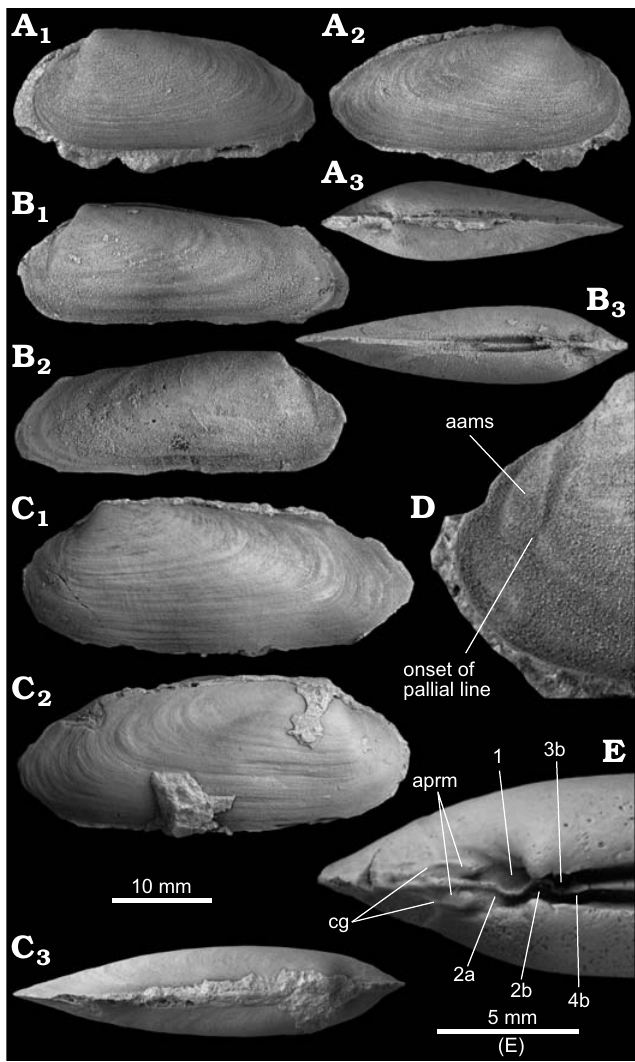
Fig. 6. The vesicomyid Pleurophopsis lithophagoides Olsson, 1931, from the early Oligocene Belén seep site, Talara Basin, northern Peru. A . Speci- men with strongly sloping posterodorsal margin (NRM Mo187014), left valve (A 1 ), right valve (A 2 ), and dorsal view (A 3 ). B . Specimen with rather straight posterodorsal margin (NRM Mo187015), left valve (B 1 ), right valve (B 2 ), and dorsal view (B 3 ). C . Large specimen (NRM Mo187016), left valve (C 1 ), right valve (C 2 ), and dorsal view (C 3 ). D . Close-up on ante- rior side of left valve (NRM Mo187018), showing anterior adductor muscle scar and onset of pallial line. E . Internal mold showing hinge and anterior muscle scars (NRM Mo187017). Abbreviations: aams, anterior adductor muscle scar; aprm, anterior pedal retractor scar; cg, connecting grove be- tween aams and